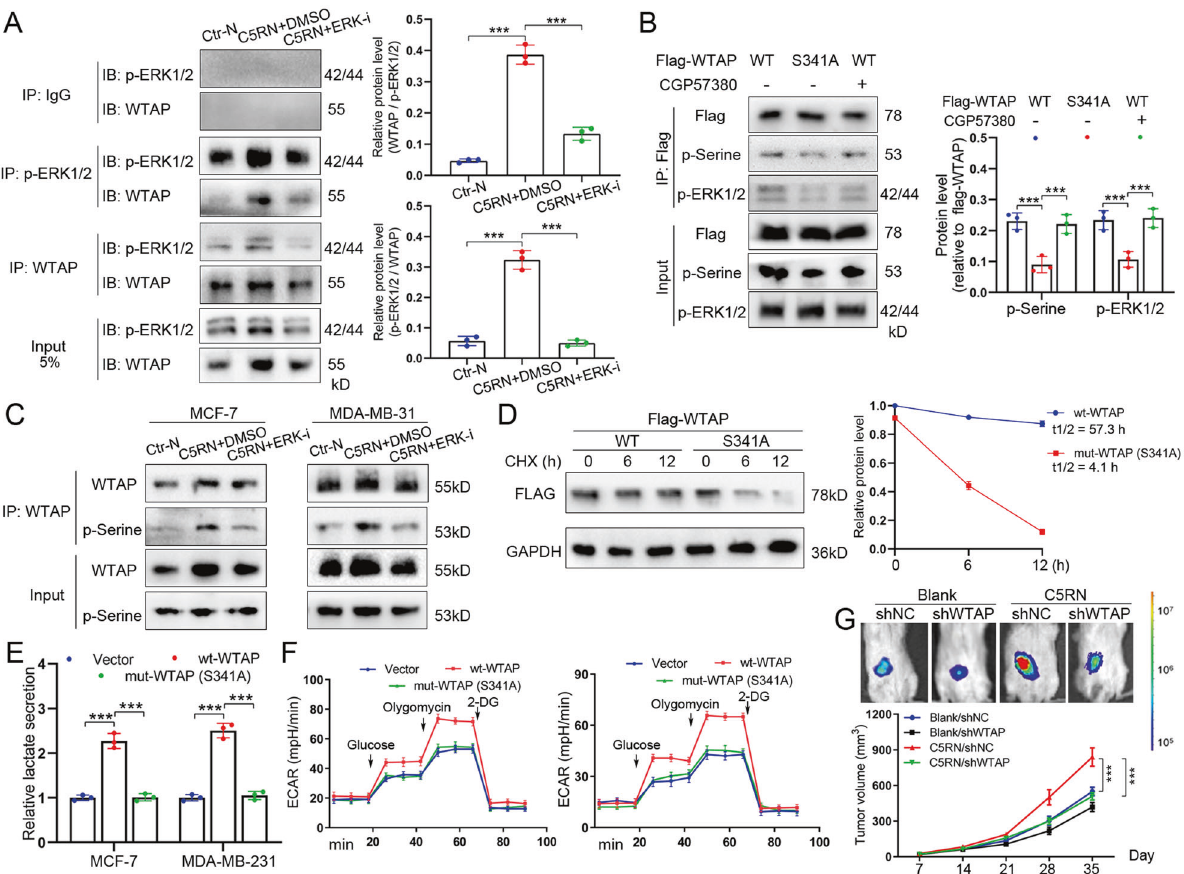
Fig. 6 WTAP phosphorylation at serine 341 by ERK1/2 stabilizes WTAP to promote breast cancer cell glycolysis. A Co-IP of WTAP with p-ERK1/2 (Thr202/Tyr204) in whole-cell extracts from MCF-7 C5RN cells with or without ERK1/2 inhibition (left). Quantitative analysis of co- interaction between WTAP and p-ERK1/2 (right). B Co-IP of p-ERK1/2 (Thr202/Tyr204) with WT or S341A mutated Flag-WTAP in whole-cell extracts from MCF-7 C5RN cells treated with or without 10 μ M CGP57380. The phosphoserine (p-Serine) of immunoprecipitated Flag-WTAP were detected using pan-phosphoserine antibody. C Immunoblotting of phosphoserine (p-Serine) of immunoprecipitated WTAP in MCF-7 C5RN and MDA-MB-231 C5RN cells with or without ERK1/2 inhibition. D MCF-7 C5RN cells were cultured by CHX (10 mg/mL) for 0 – 12 h. Lysates were used to measure the protein levels of FLAG. The relative fold is indicated and plotted in the right panel. E Lactate production was examined in MCF-7 and MDA-MB-231 cells transfected with vector, wild-type, or mutant WTAP (S341A). F Analysis of ECAR in MCF-7 and MDA-MB-231 cells transfected with vector, wild-type, or mutant WTAP (S341A). G Effects of breast cancer cells with C5RN culture and shWTAP transfection on tumor growth using mice model. The volumes are measured every 7 days. Data represent the mean ± SD of at least three independent experiments. *** P < 0.001, Ctr-N C5aR1-negative neutrophils.